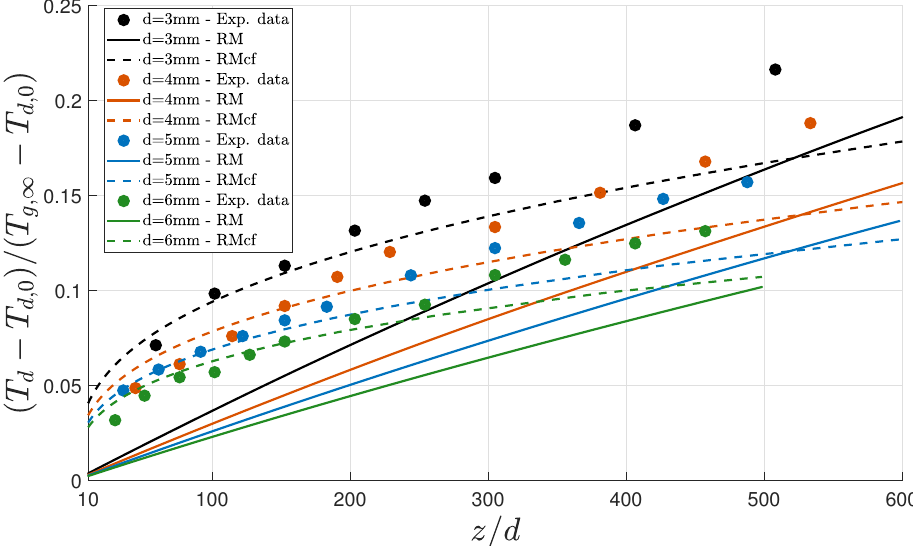
Figure 4. Variation in the temperatures of single water droplets falling through the air, subjected to a humidity ratio of